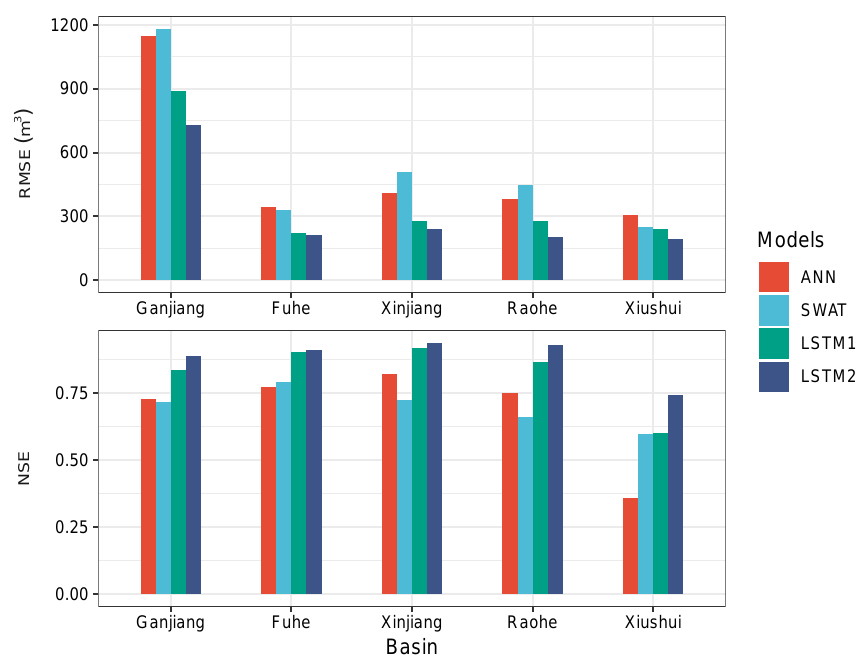
Figure 9. Performances of LSTMs, ANN and Soil & Water Assessment Tool (SWAT) model in simulating the